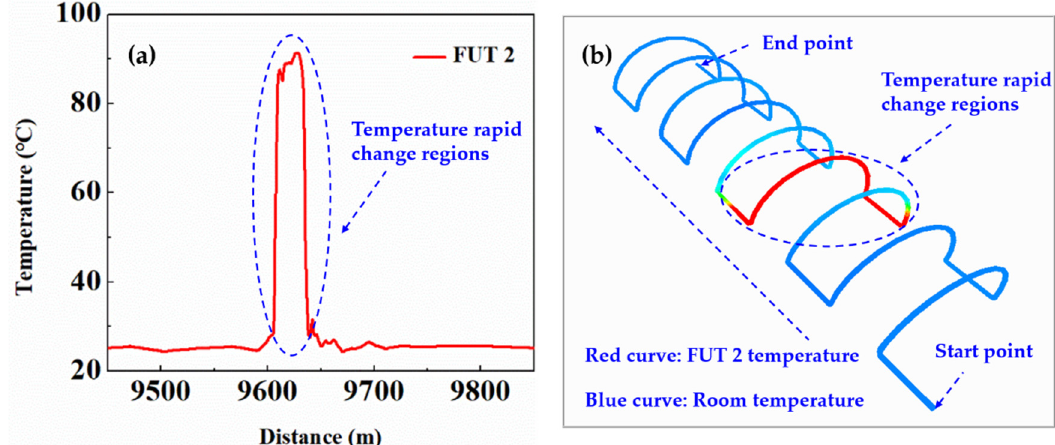
Figure 9. ( a ) The temperature trace at the sensing section of FUT 2; ( b ) The mapping results of 2D temperature trace to visual model of the longitudinal lining model (LLM).